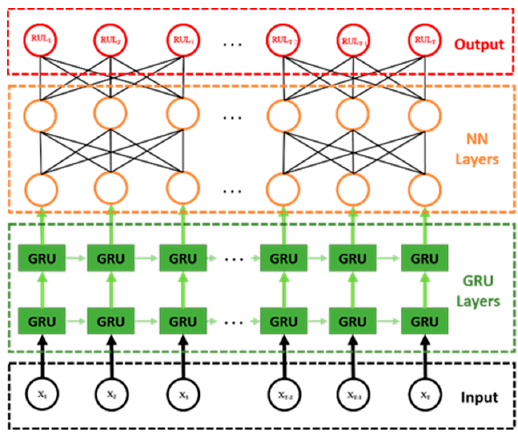
Figure 6. Model structure of AE-GRU for RUL prediction.